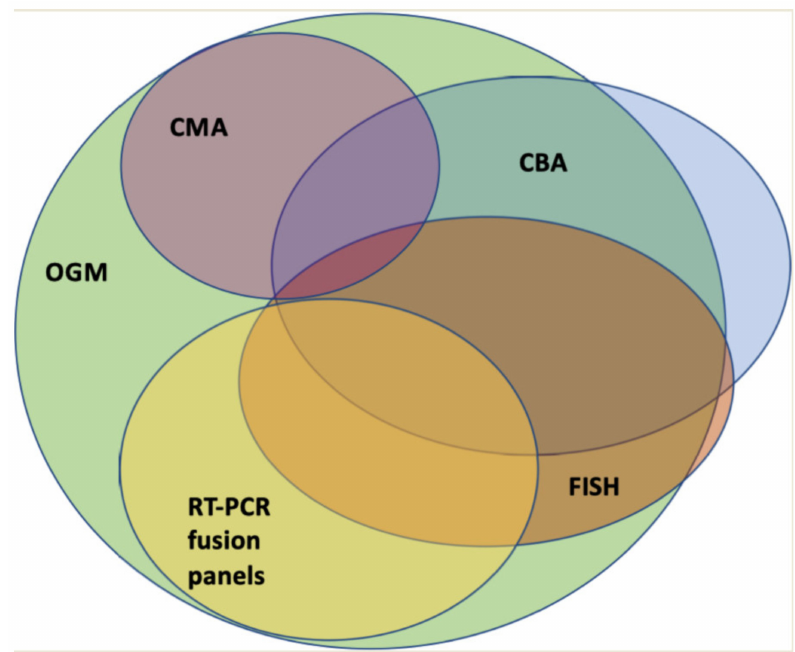
Figure 2. Schematic Graphical illustration of standard cytogenetic methods and OGM based on the data of Gerding et al. and Vangala et al. (quantitatively inaccurate) [27,28]. The vast majority of variants detected by conventional methods are visible by OGM, which, furthermore, enables the detection of a wider range of aberrations, i.e., novel variants, not visible by other techniques. However, a subset of variants, especially in highly repetitive regions such as telomeres and centromeres, might not be